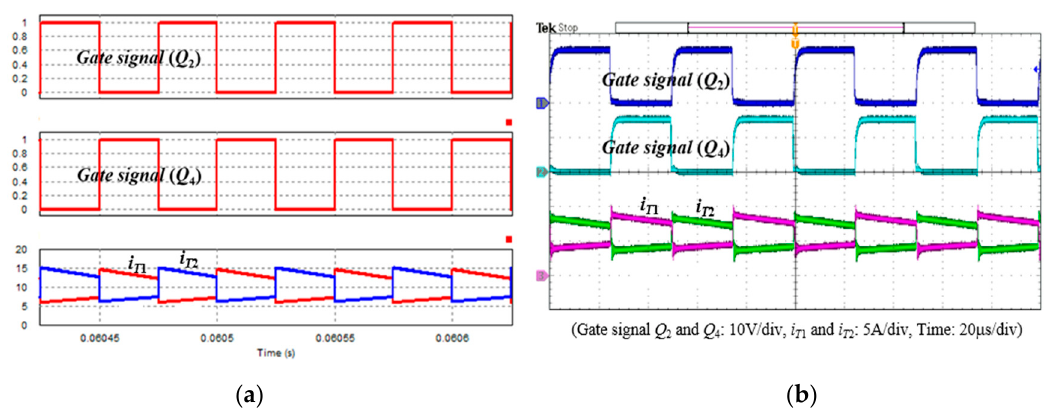
Figure 15. Waveforms of the switching gate signals and the primary-side currents of the coupled inductor in the battery charge mode with D c = 0.5: ( a ) simulated and ( b ) experimental.